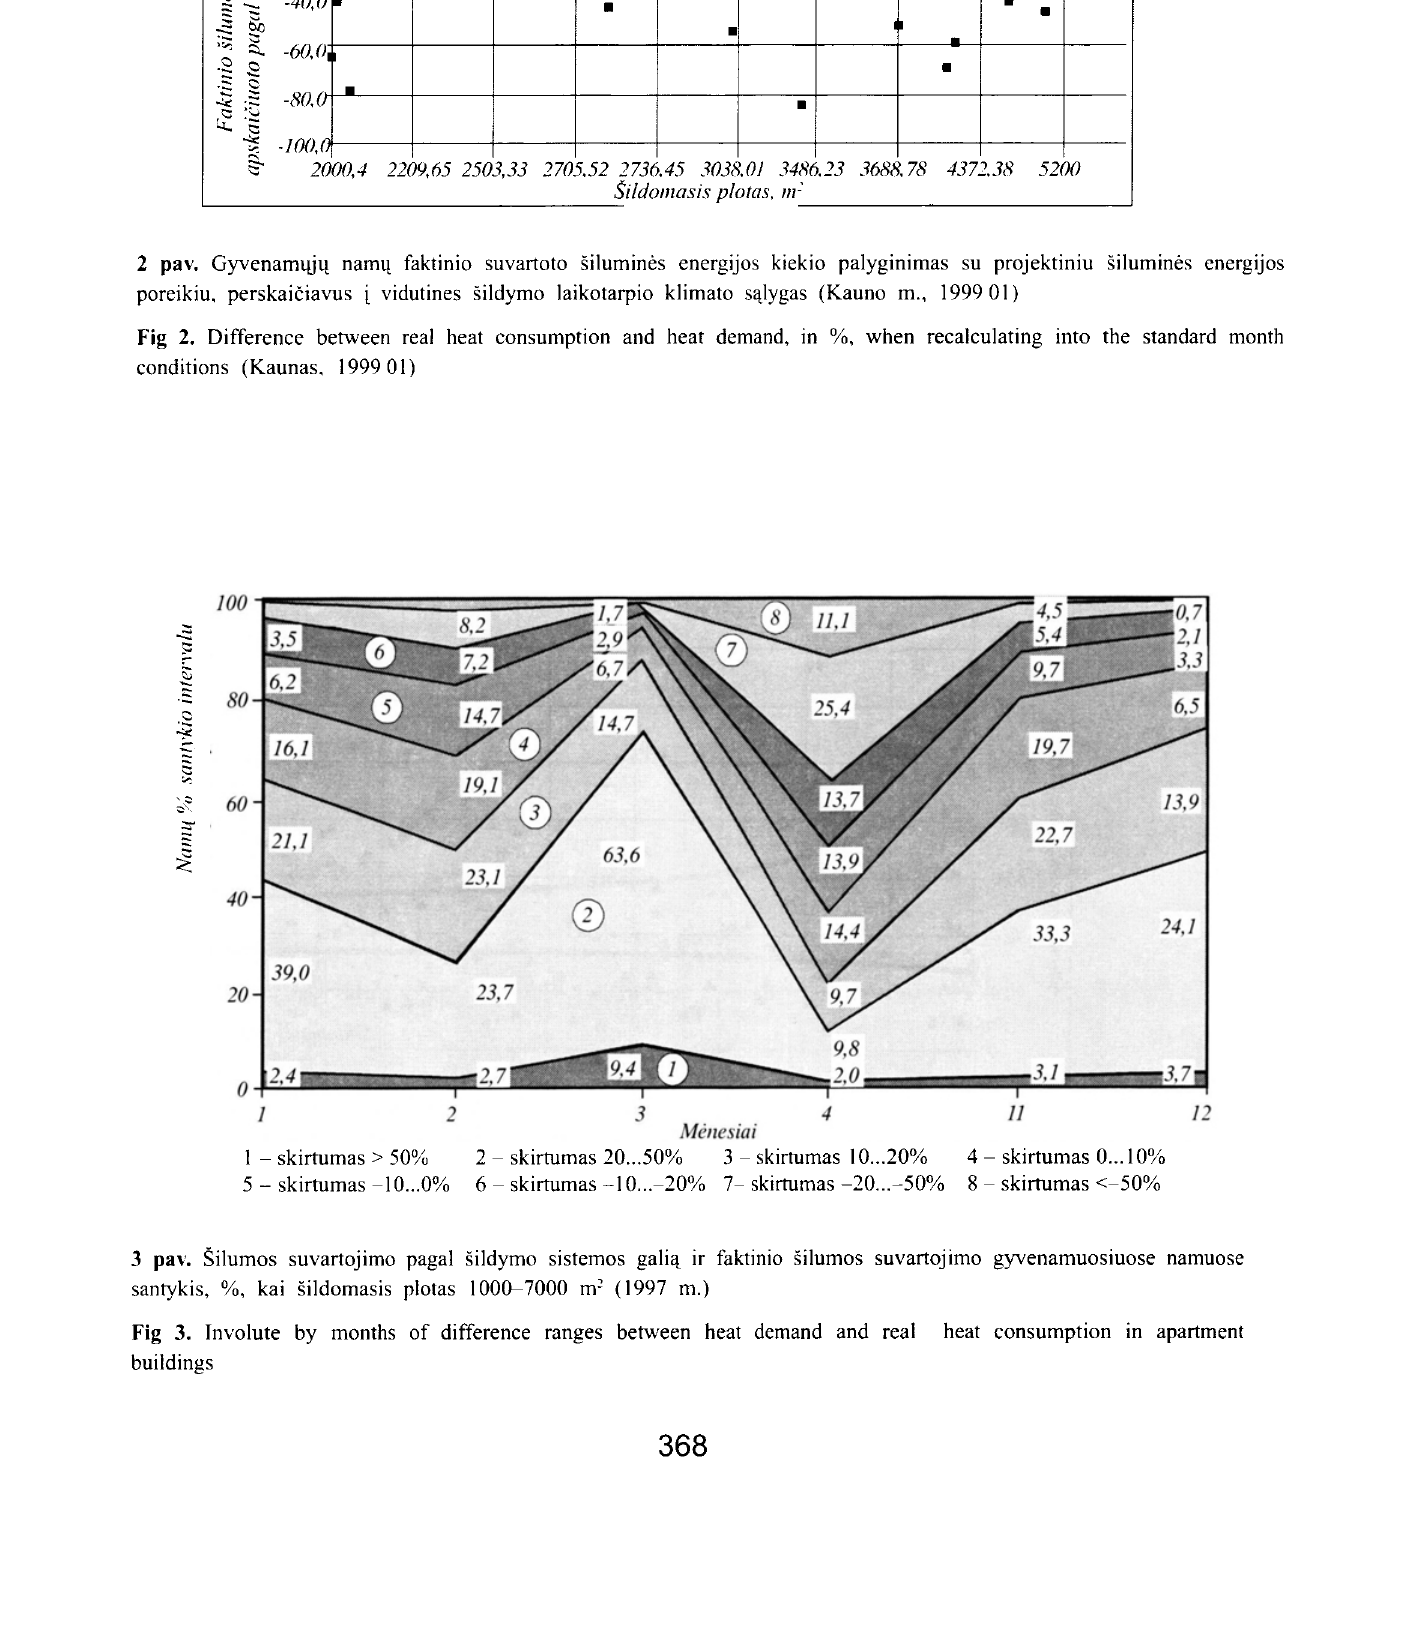
Fig 3. Involute by months of difference ranges between heat demand and real heat consumption m apartment